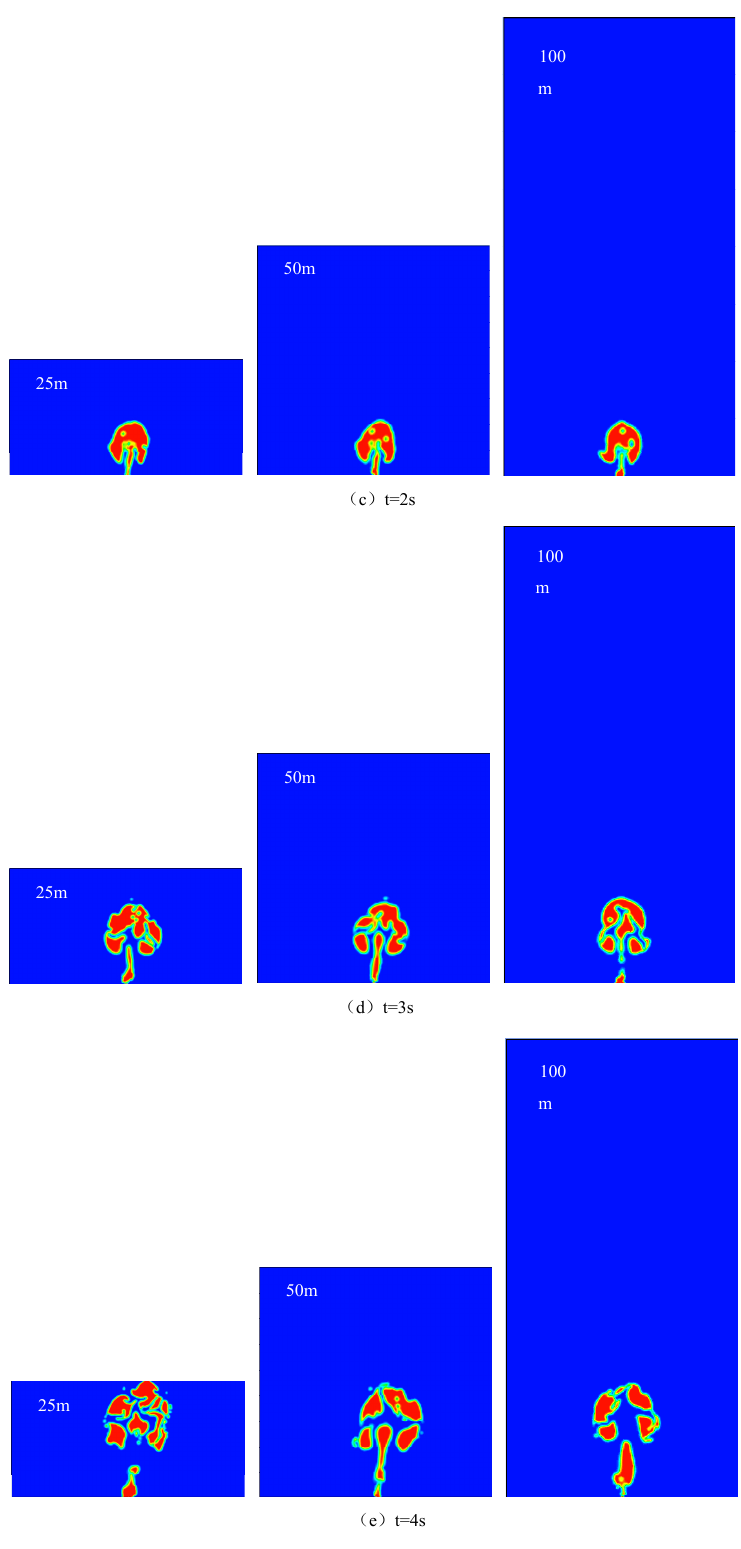
Figure 5. Cloud chart of submarine gas leakage and diffusion at each time when the water depth is 25 m, 50 m and 100 m, respectively.